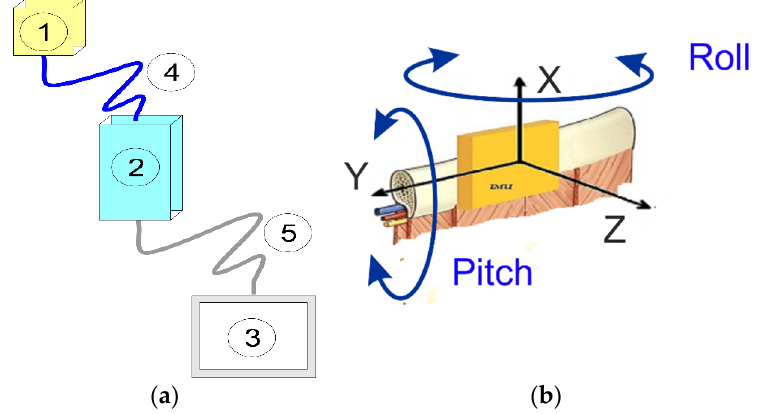
Figure 1. The conceptual design of a SENSIRIB device: ( a ) the scheme; ( b ) the IMU sensor charac- teristics.